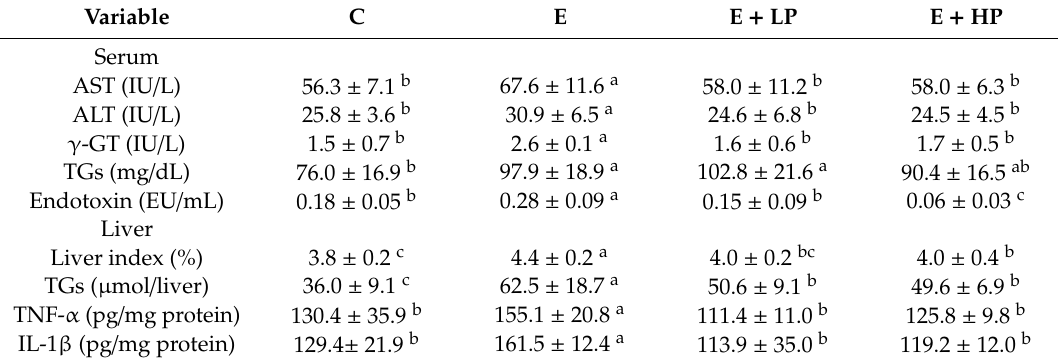
Table 2. Serum and liver biochemical analysis of mice at the end of the